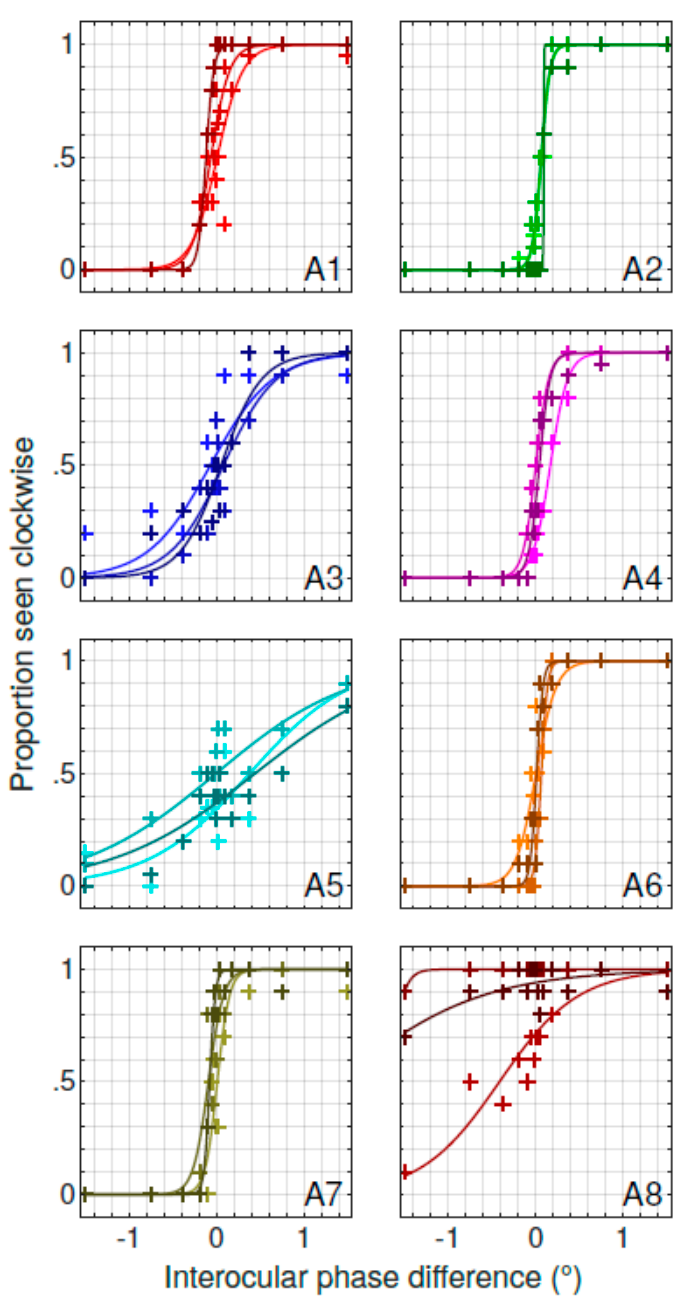
Figure 3. Variability of the PSE. The three repetitions (10 blocks each, light to dark shades) of the psychometric functions of the perceived direction of rotation as a function of the interocular phase difference for all amblyopic subjects ( A1 – A8 in each panel). Data points are fitted by a logistic function.